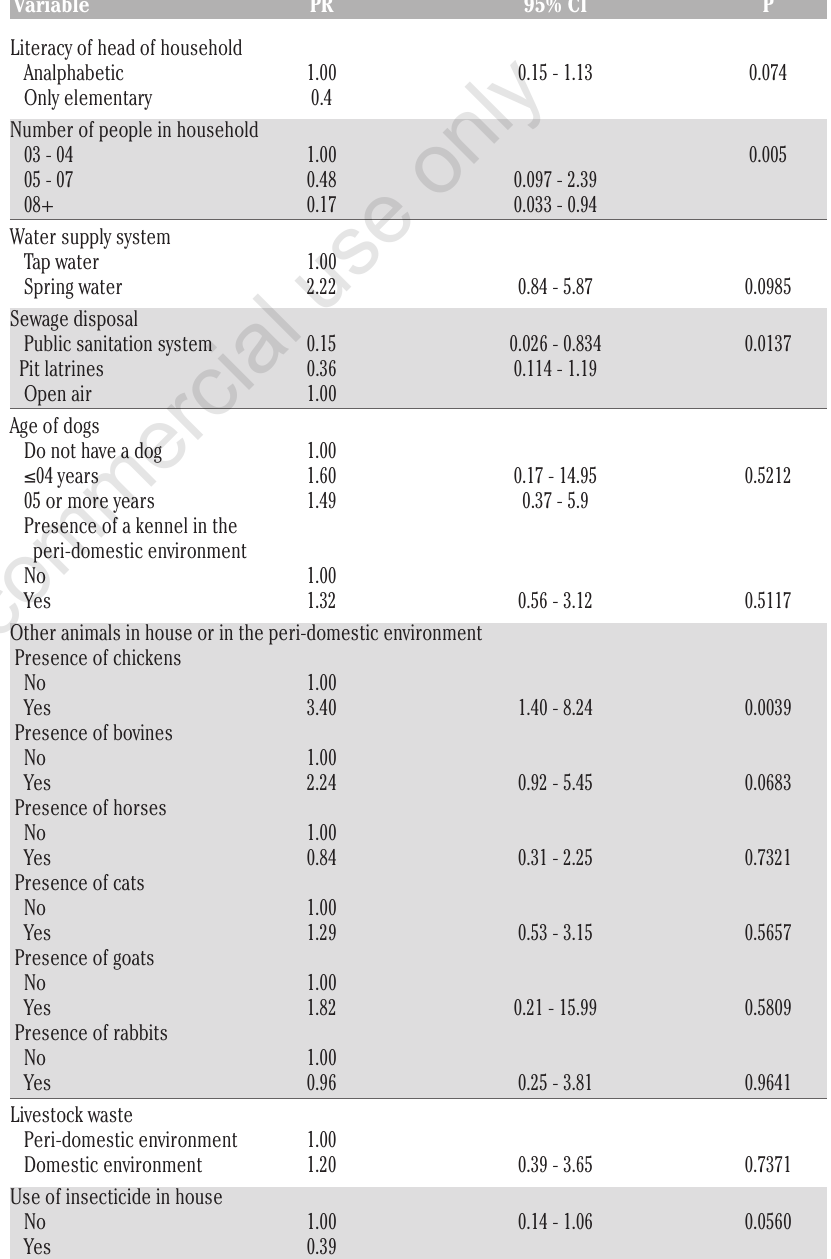
Table 4. Study of same socio-economic and environmental factors associated to risk of transmission of Leishmania infantum in two endemic areas in northern Morocco (Taounate and My Yacoub). Prevalence ratios (PR) and their 95% confidence intervals (95% CI).